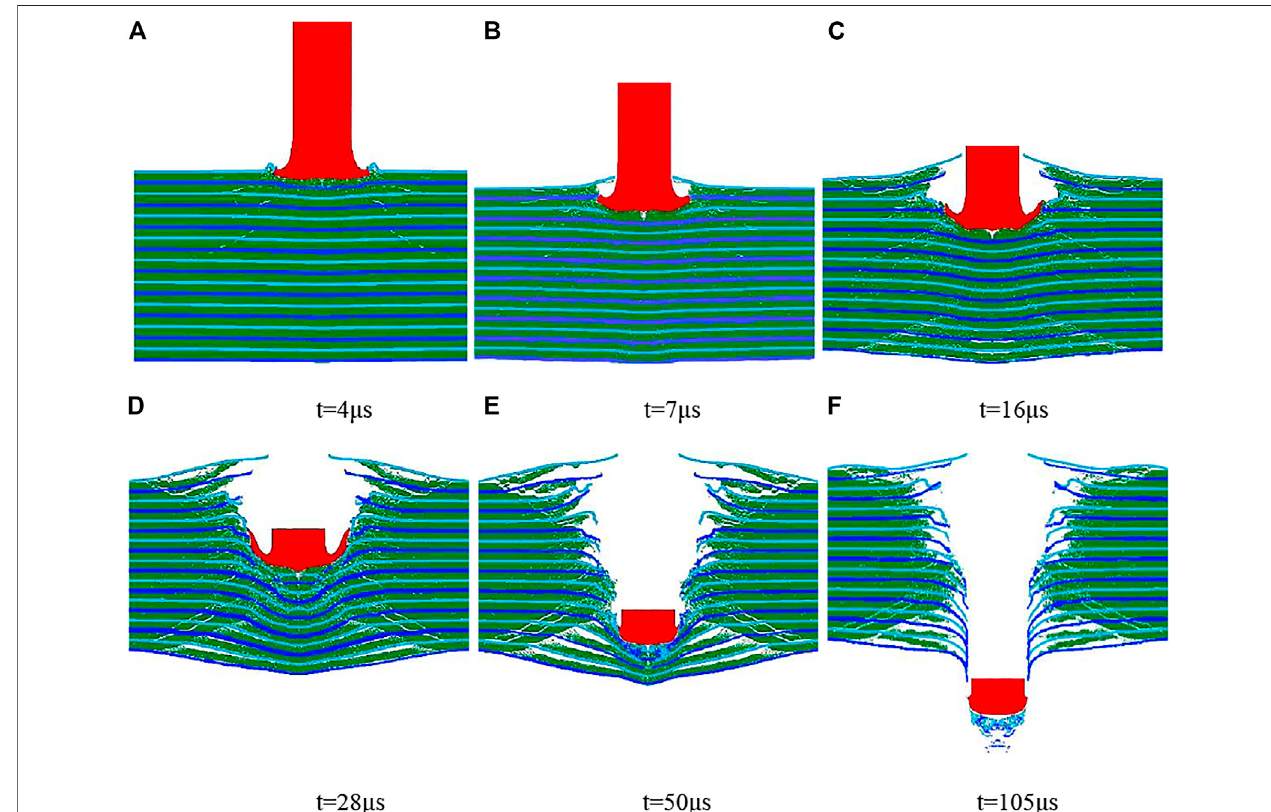
FIGURE 7 | Schematic diagram of stress wave propagation in a three- layer structure.